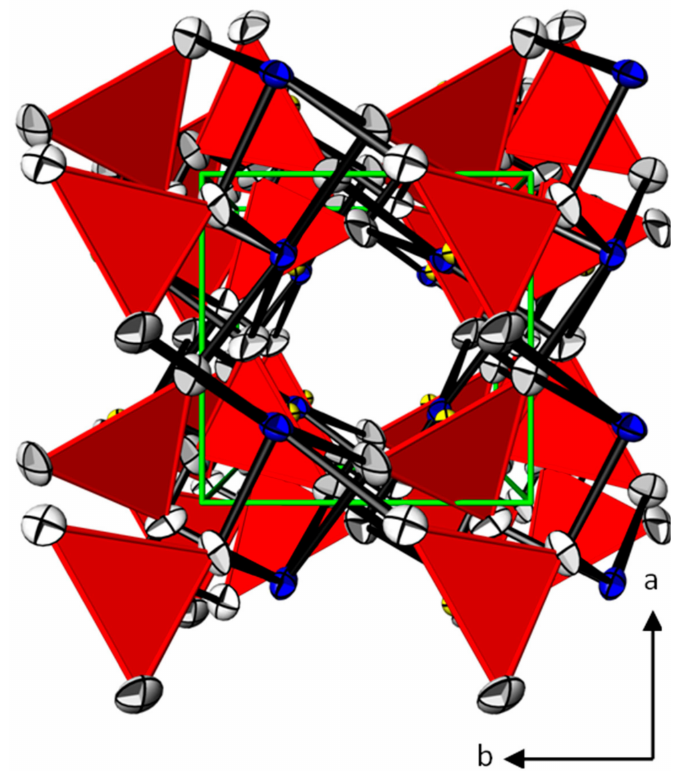
Figure 3. The crystal structure of β -PbTeO 3 in a perspective view along [001]. Colour codes and displacement ellipsoids are as in Figure